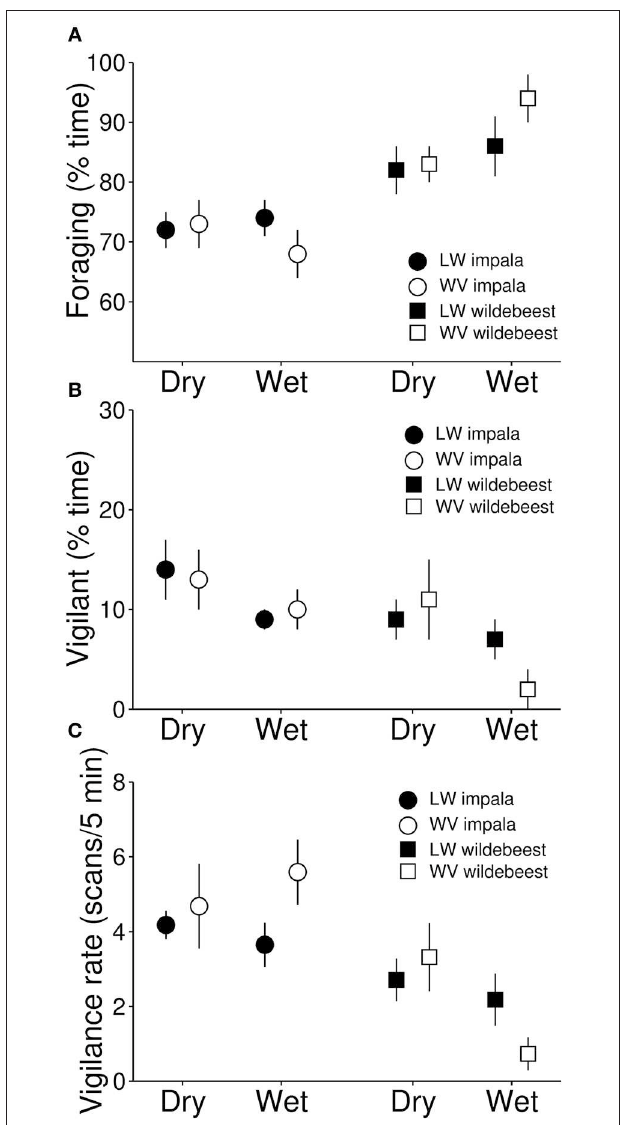
FIGURE 2 | Proportion of time spent foraging (A) , proportion of time spent vigilant (B) and vigilance scan rates (scans/5min observation period; C ) calculated from a total of 413 individuals during 5min focal observations conduced on 42 groups of impala and 29 groups of wildebeest in Lapalala and 16 groups of impala and 14 groups of wildedebeest in Welgevonden. The figure represents means of group means ± 1